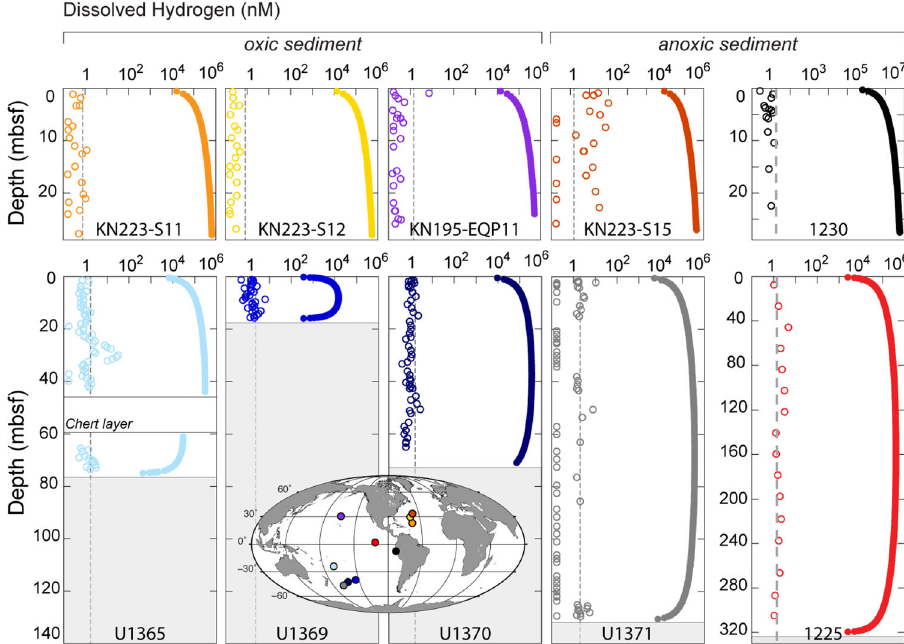
Fig. 2 Sedimentary pro fi les of dissolved H 2 concentrations. Dissolved H 2 concentration pro fi les for North Paci fi c Site KN195-EQP11, South Paci fi c IODP Sites U1365, U1369, U1370, and U1371, North Atlantic Sites KN223-11, KN223-12 and KN223-15, Equatorial Paci fi c ODP Site 1225, and Peru Trench ODP Site 1230. Open symbols mark measured H 2 concentrations. Solid symbols represent H 2 concentrations expected from radiolytic H 2 production and diffusion in the absence of in situ H 2 consumption. Gray vertical lines mark detection limits for dissolved H 2 concentration measurements. The detection limit of the applied analytical protocol was de fi ned as the mean of the repeated procedural blank measurements plus three times their standard deviation. Symbol colors match site locations in Fig.